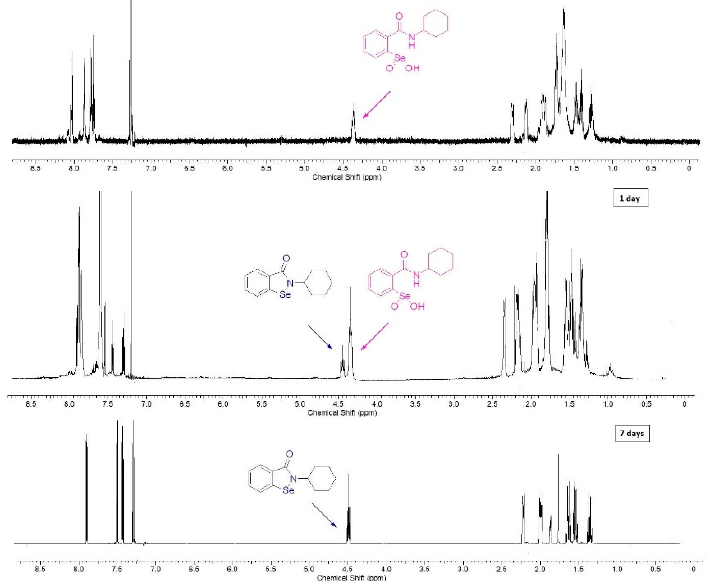
Figure 1. Decomposition of benzeneseleninic acid 15 to the corresponding benzisoselenazolone.